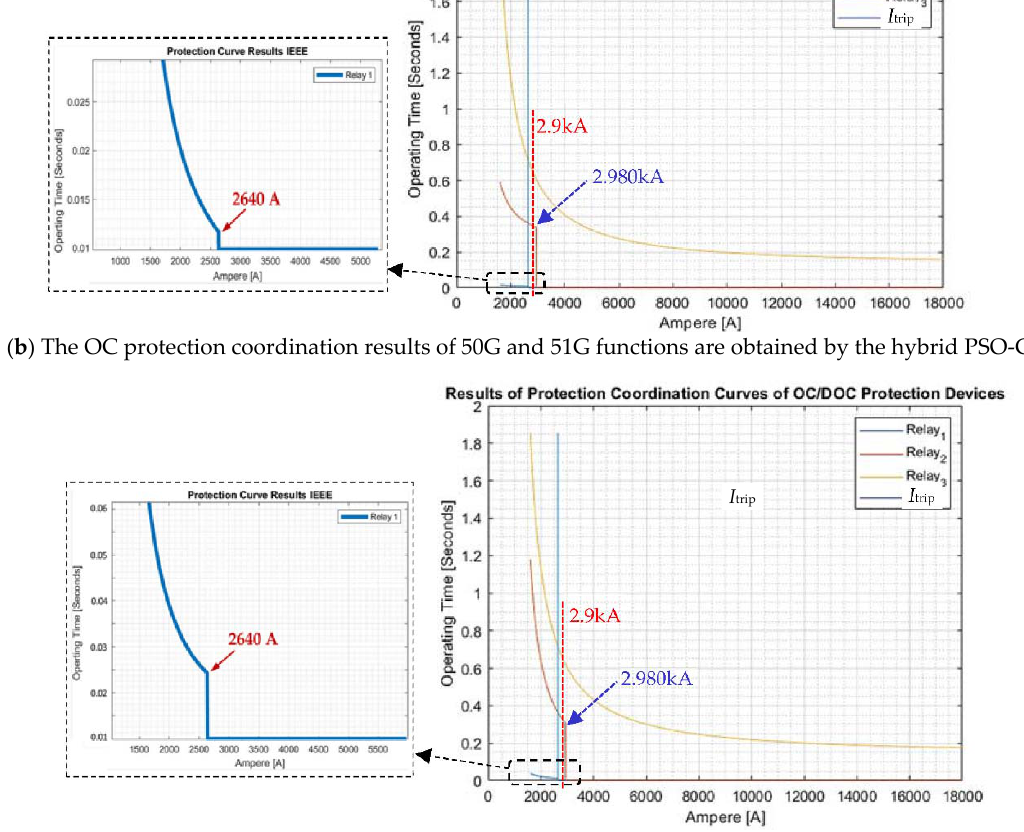
Figure 13. Optimal protection characteristic curves of the OC relays in Scenario 4 of the 22 kV distribution system.